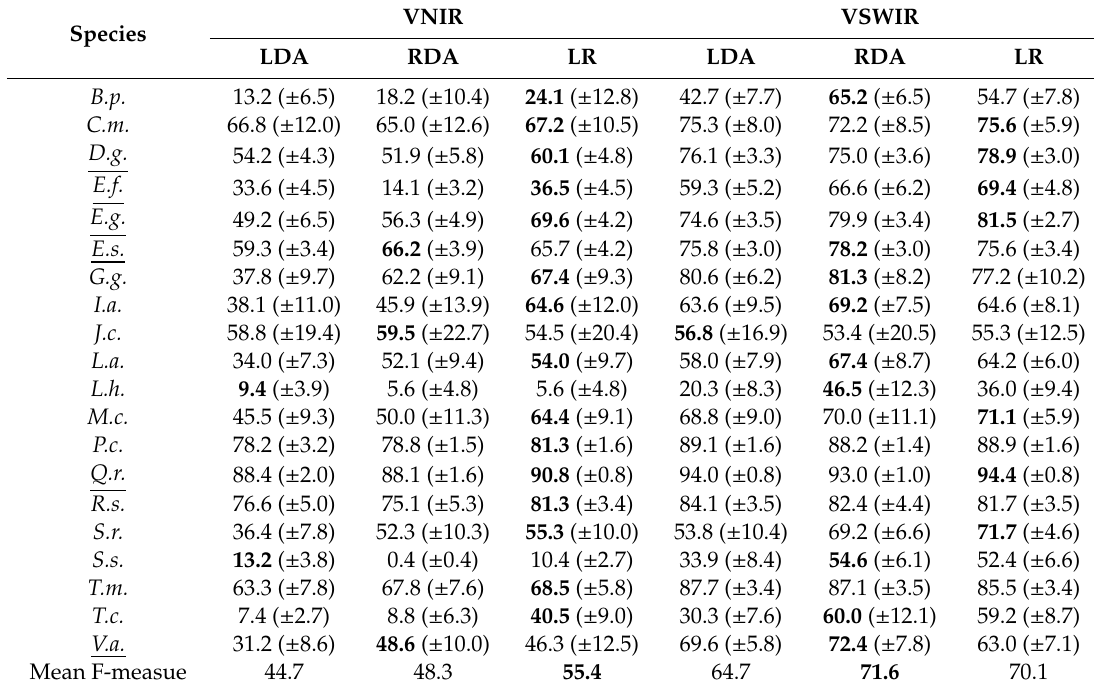
Table A1. Pixel-level results from the one versus 19 other species method. Only the F-measure is given with the standard deviation. The best prediction for each species with either VNIR or VSWIR information is in